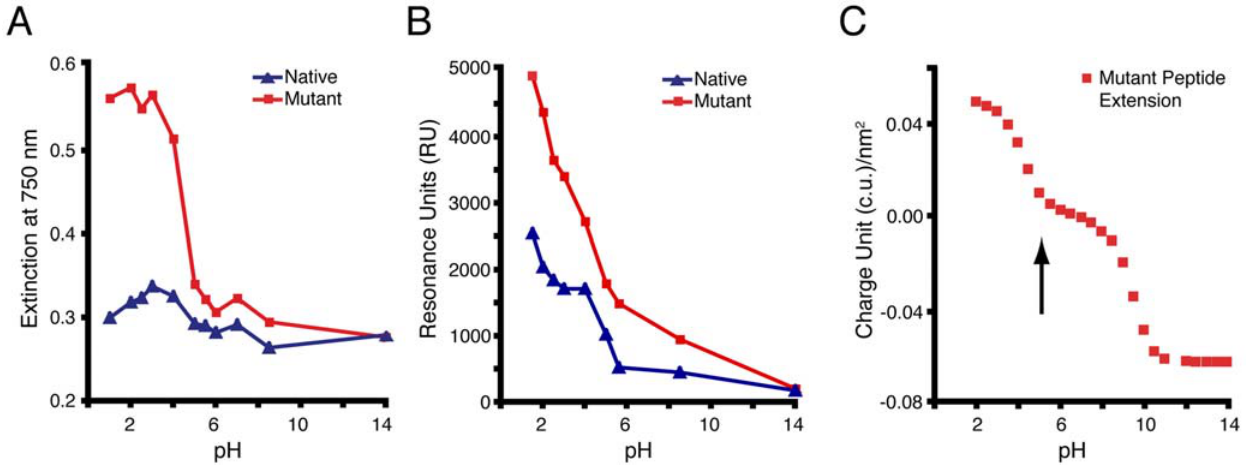
Figure 4. Differences in light extinction and SPR signal between the native and mutant Au-phage hydrogels as a function of pH. (A) Light extinction at 750 nm for hydrogels as a function of pH. (B) SPR measurements of phage interaction with citrate-treated Au surface vs. pH (buffer background signal subtracted from data). (C) Surface charge density calculation based on individual amino acid charge present on mutant peptide extension.